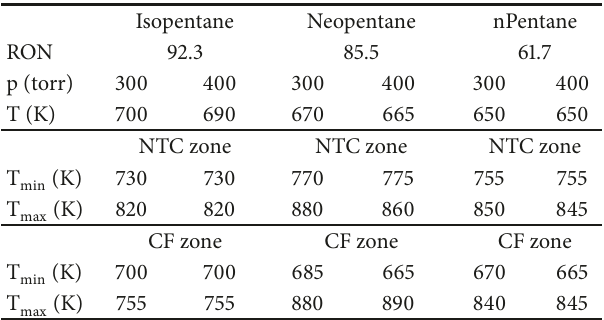
Table 6: Pentane isomers’ properties and autoignition criteria for stoichiometric hydrocarbon/air mixtures, adopted from